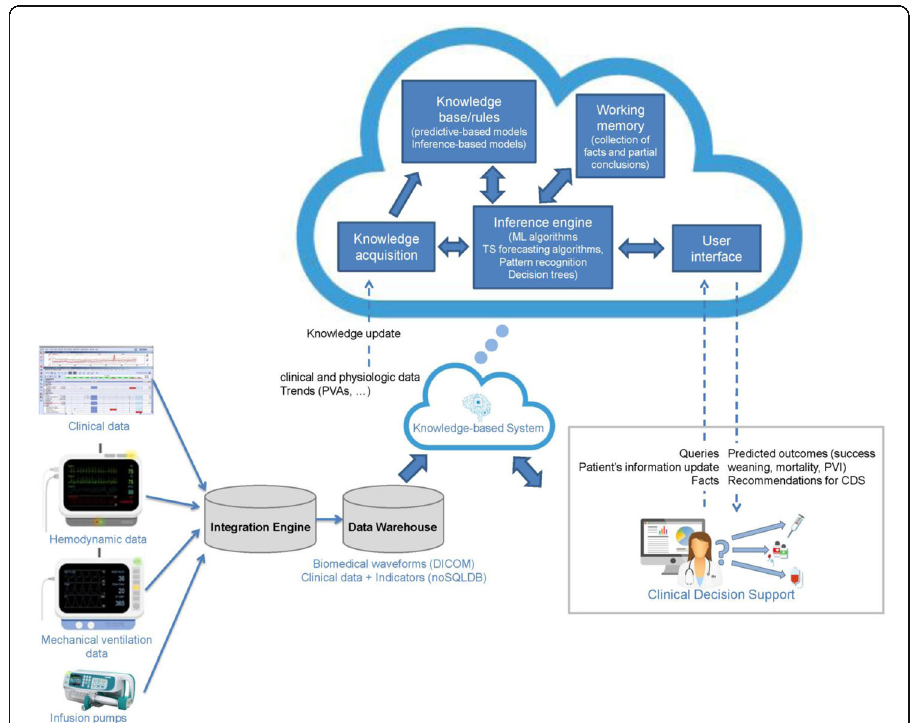
Fig. 3 Future medical trends in real-time clinical decision making for mechanically ventilated critically patients in ICU. With adequate interoperability and data storage, clinical decision support systems based on big data analytics can automatically recognize patterns in data; moreover, these systems have the ability to improve continuously by “ learning ” from past and new inputs. Using the cloud for big data analytics